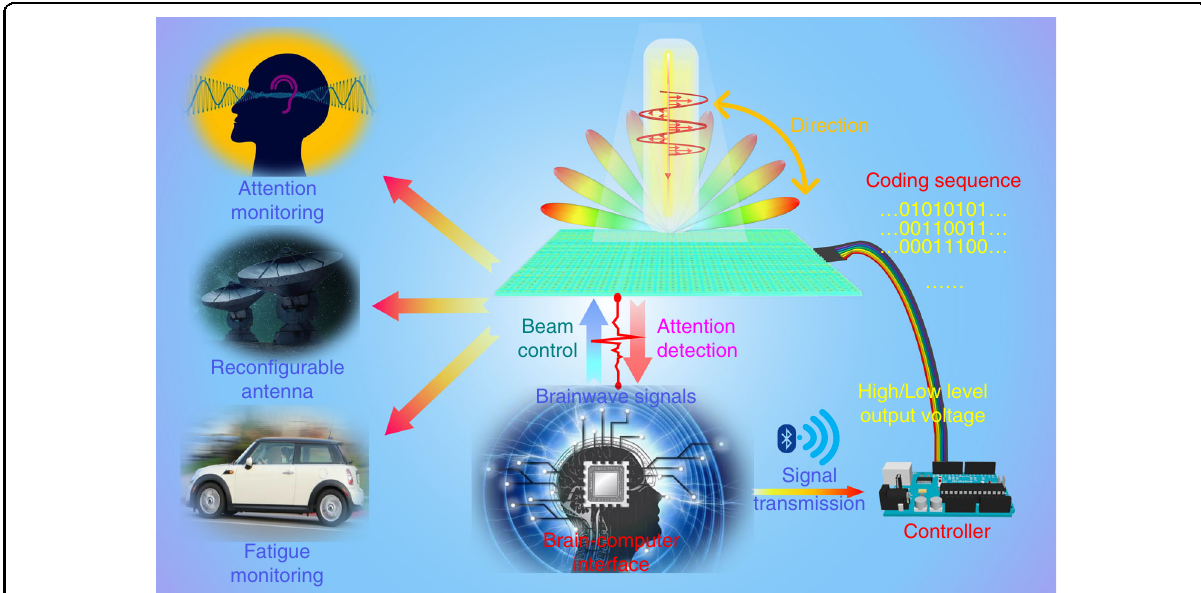
Fig. 2 Schematic diagram of remotely mindcontrolled metasurfaces via brainwaves. To achieve remote control, brainwaves signals are transmitted wirelessly from the user to the controller via Bluetooth. A brainwave extraction module is employed to extract the user ’ s attention intensity signal, which is then used as the control signal of programmable metasurfaces. Reprinted with permission from Ref. 9 , Copyright